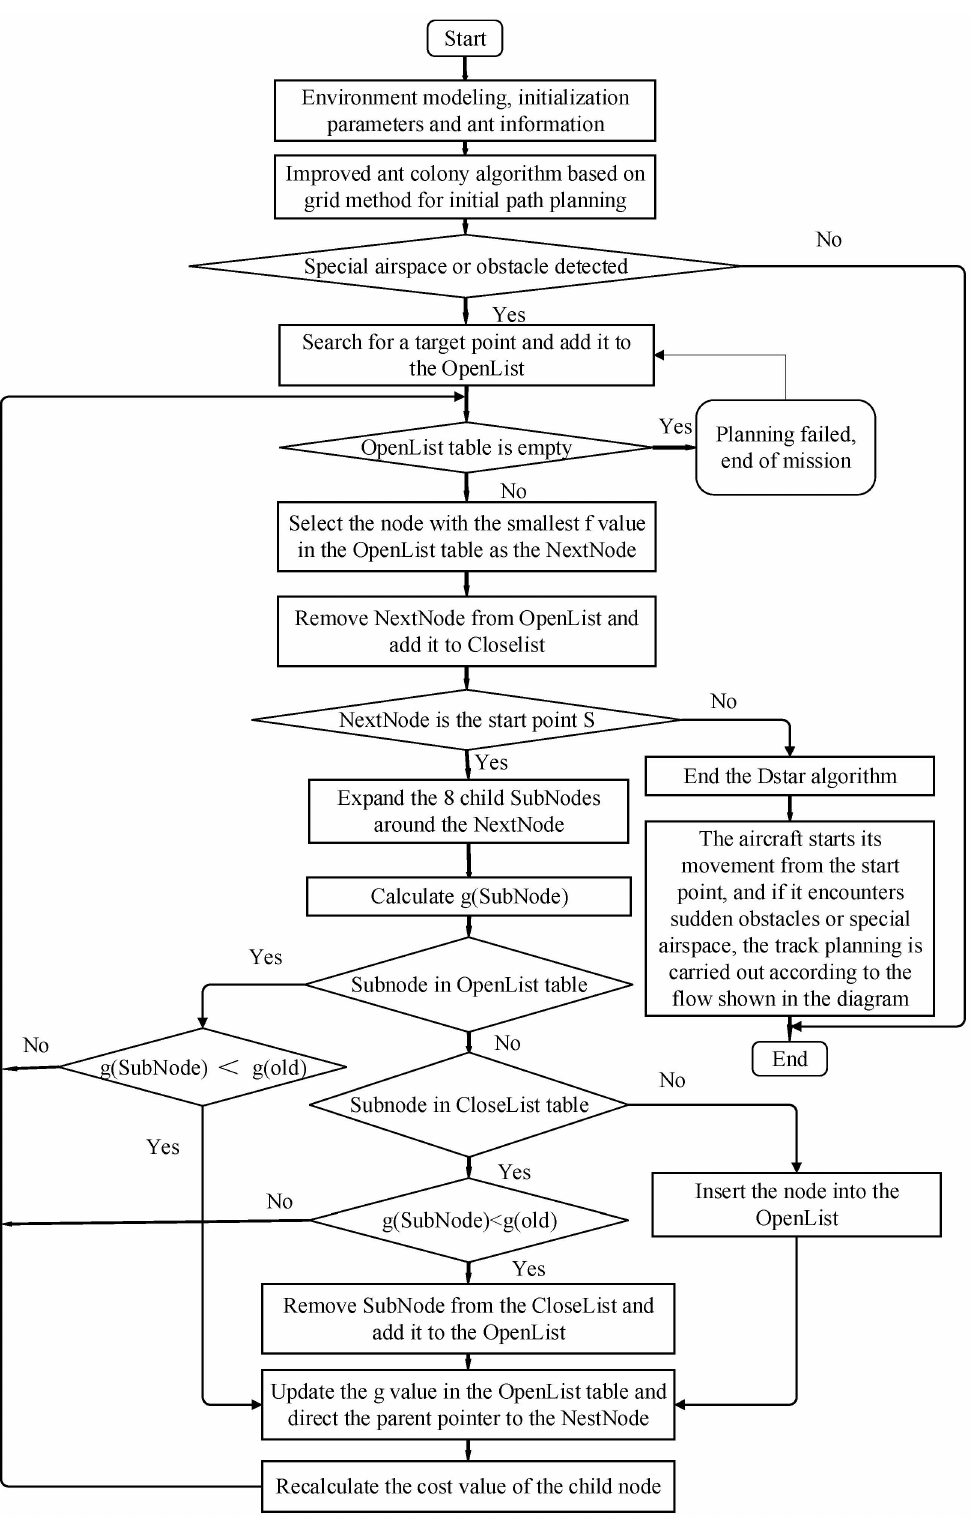
Figure 8. Flowchart of the improved hybrid D*–ant colony algorithm. When a track is planned, the origin point of the map model is set to s and the destina- tion point to d . The “open list” and “close list” are created as empty linked lists to store information about the road